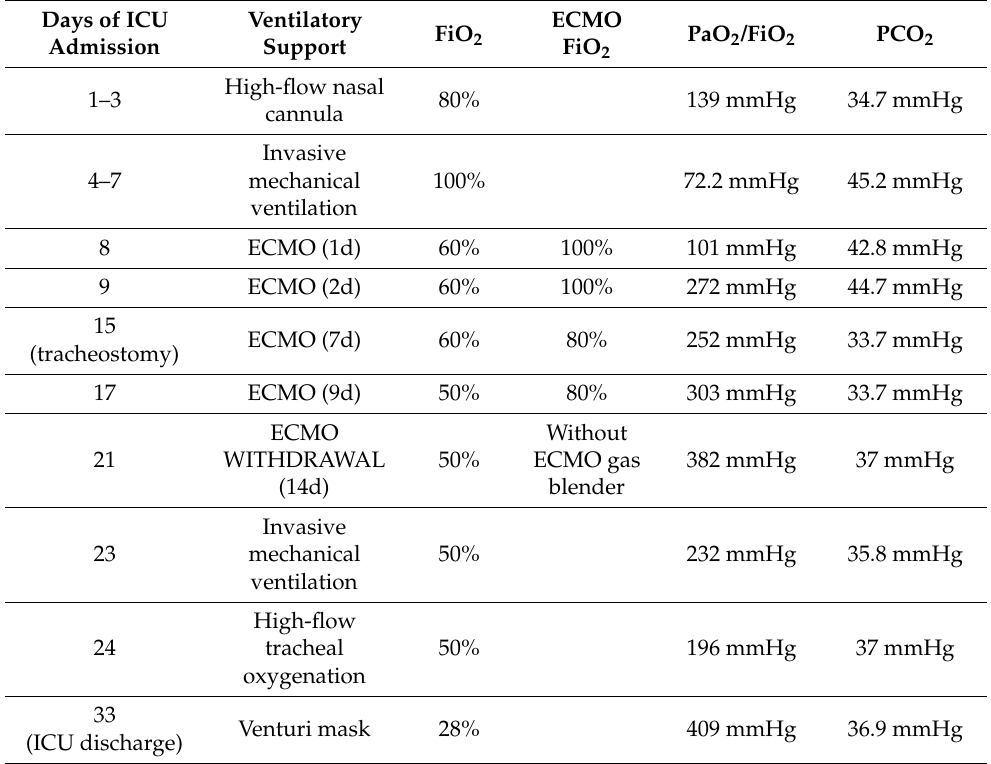
Table 1. Gasometric data during ICU